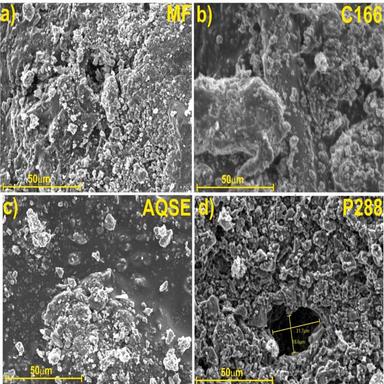
SEM micrographs, at ×1000 magnification for: a) MF, b) C166, c) AQSE and d) P288 with a pore of 31.7 μm–18.6 μm can be observed.